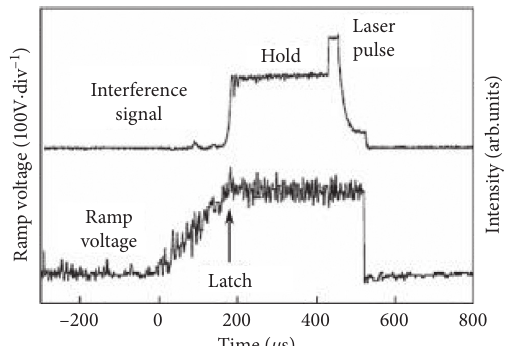
Figure 15: Schematic showing the principle of the Ramp-hold-fire resonance detection technology